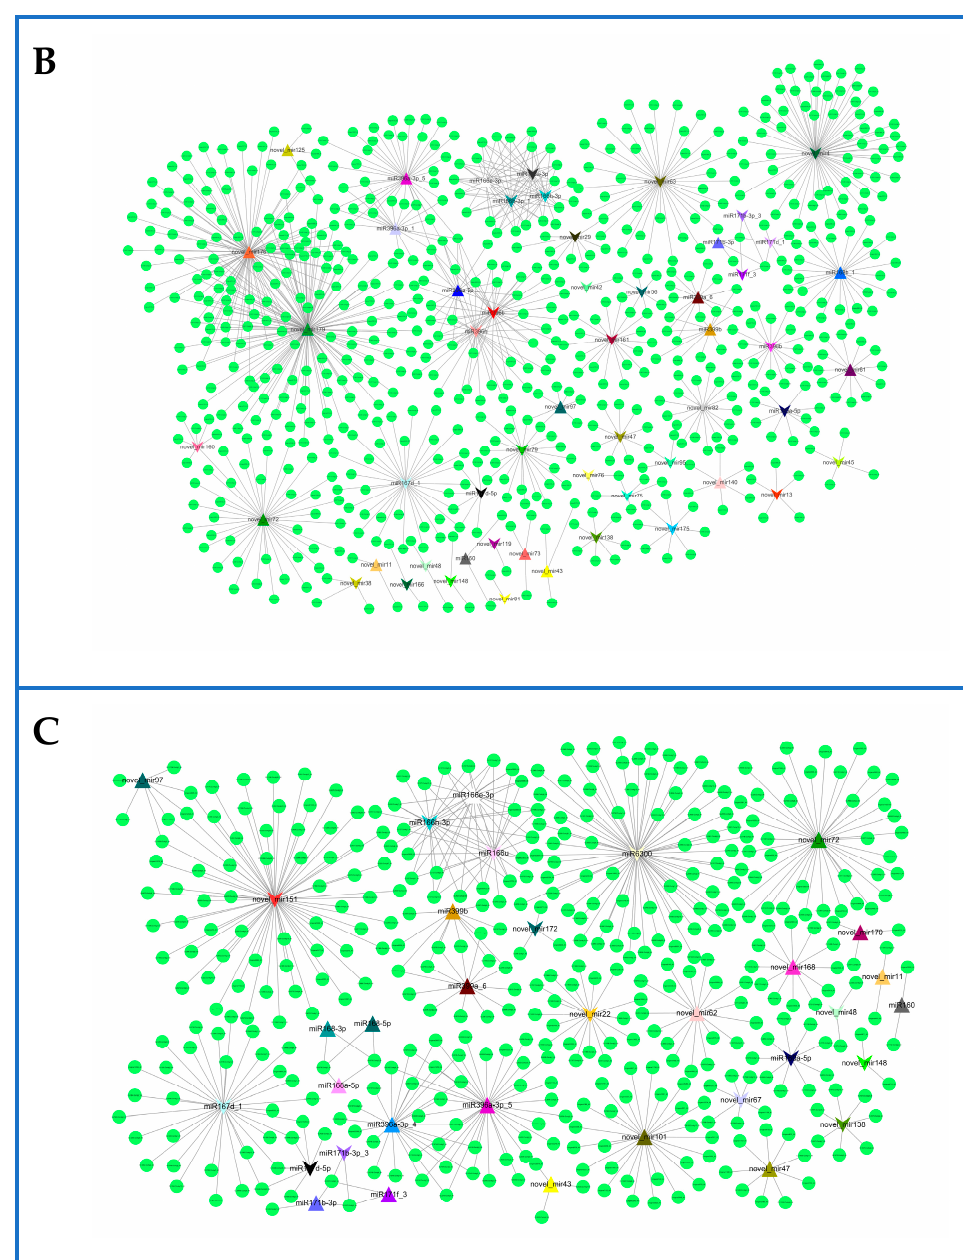
Figure 6. Network of MeJA-responsive miRNAs and their targets. Network analysis was performed using the Cytoscape network platform. ( A ) The interaction network in CKvsM10; ( B ) The interaction network in CKvsM50; ( C ) The interaction network in CKvsM50; Colored triangle nodes represented miRNAs, and circular nodes represented mRNAs. Solid lines indicated interaction associations between miRNAs and mRNAs.